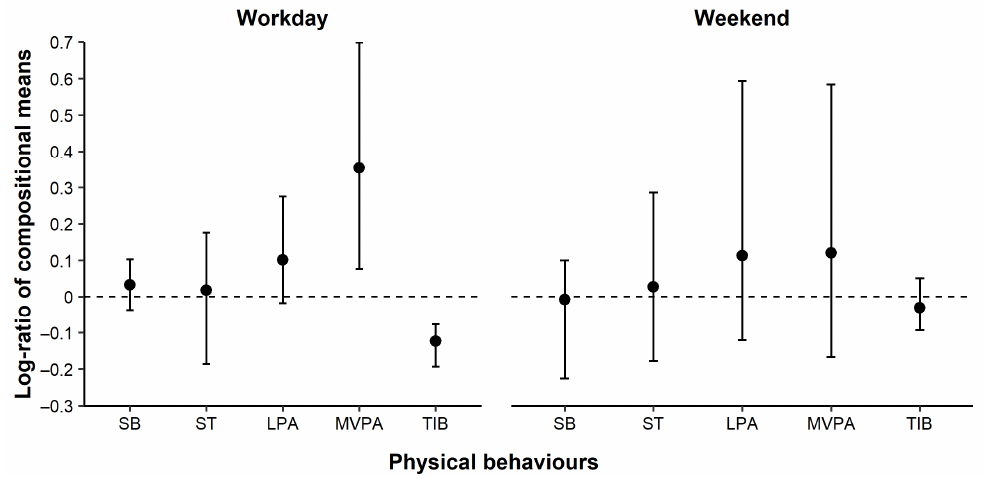
Figure 2. Log-ratios (circles) with bootstrap 95% percentile confidence intervals (vertical lines) between compositional means pre-COVID19 (numerator) and during-COVID19 (denominator) on workdays (a, left panel, n = 11) and during weekends (b, right panel, n = 11). A positive log-ratio shows that workers spent more time in that behaviour pre-COVID19 than during-COVID19, and vice versa if the log-ratio is negative. If a confidence interval includes zero, the difference was not significant at a p < 0.05 level. Abbreviations: SB, sedentary behaviour; ST, standing time; LPA, light physical activity; MVPA, moderate-to-vigorous physical activity; TIB, time-in-bed.